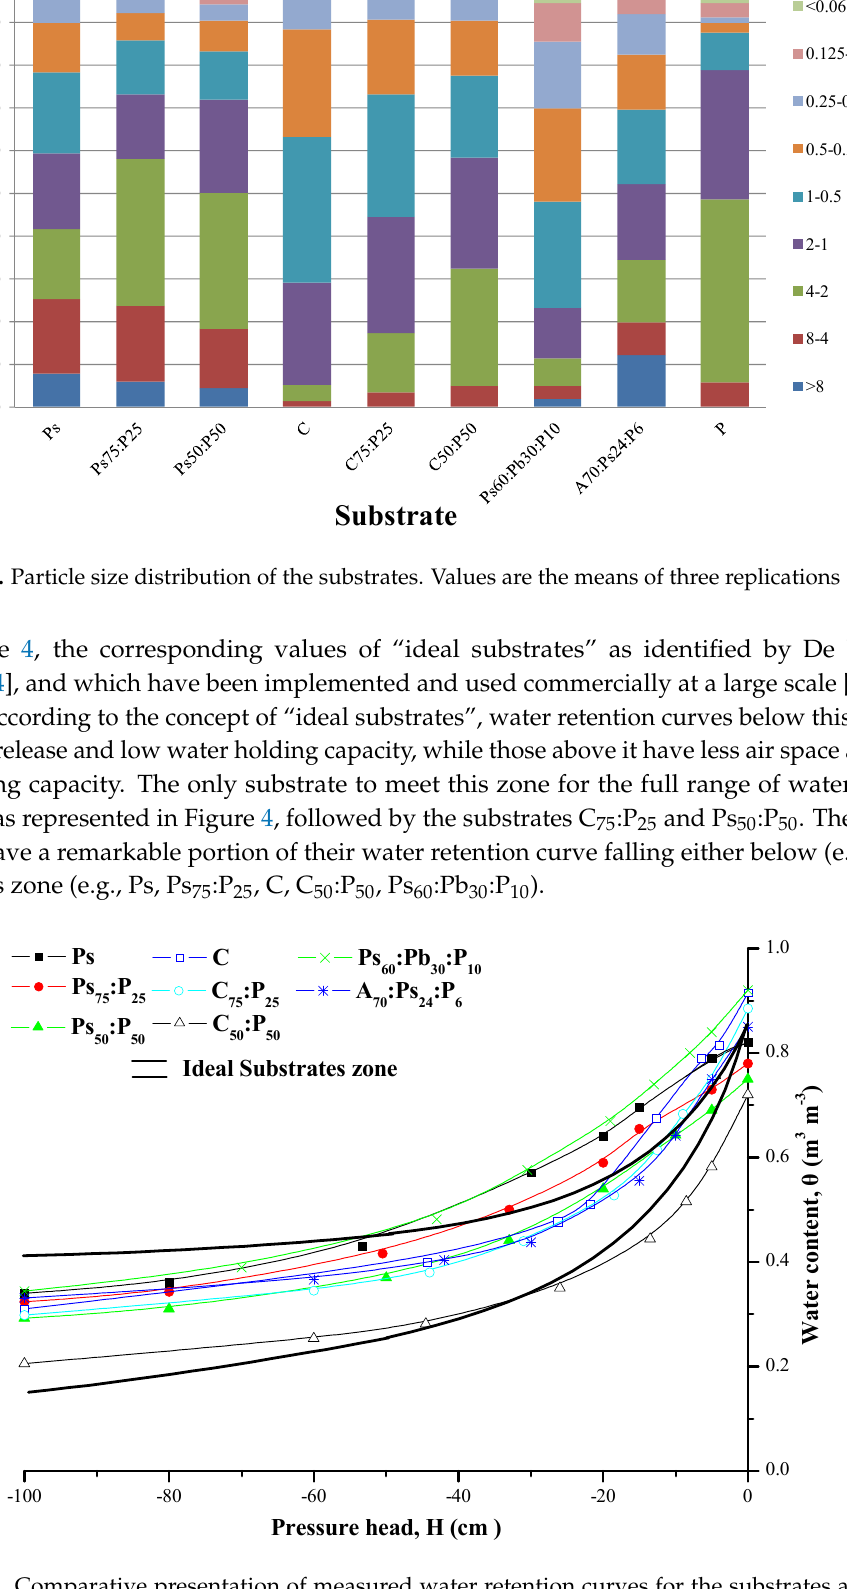
Figure 4. Comparative presentation of measured water retention curves for the substrates and the “ideal substrates zone” identified by De Boodt and Verdonck [24].